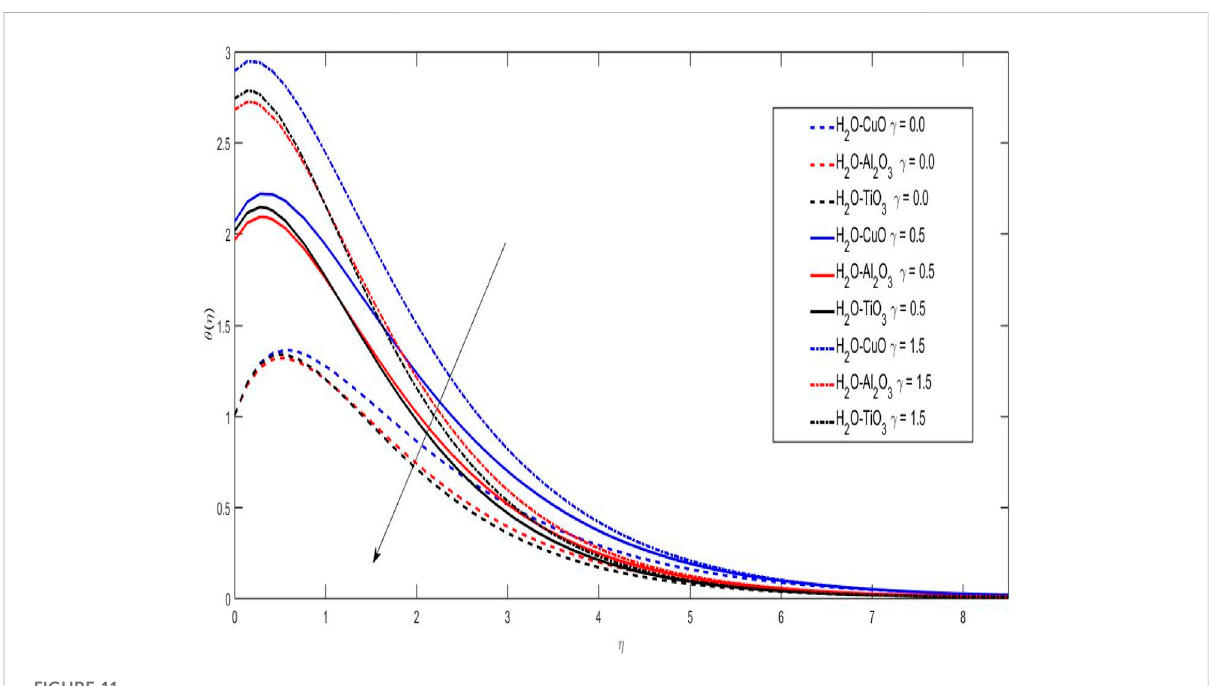
FIGURE 11 Temperature thermal effects alter vs. pro fi le.